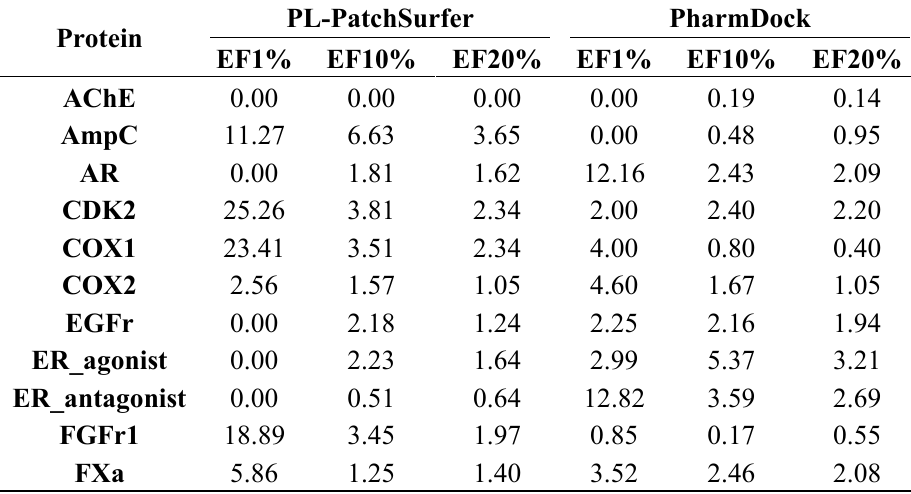
Table 3. Enrichment factors for PL-PatchSurfer and